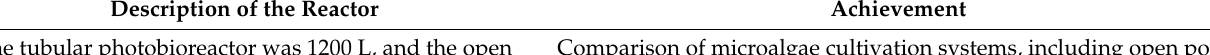
Table 10. Cont. Description of the Reactor